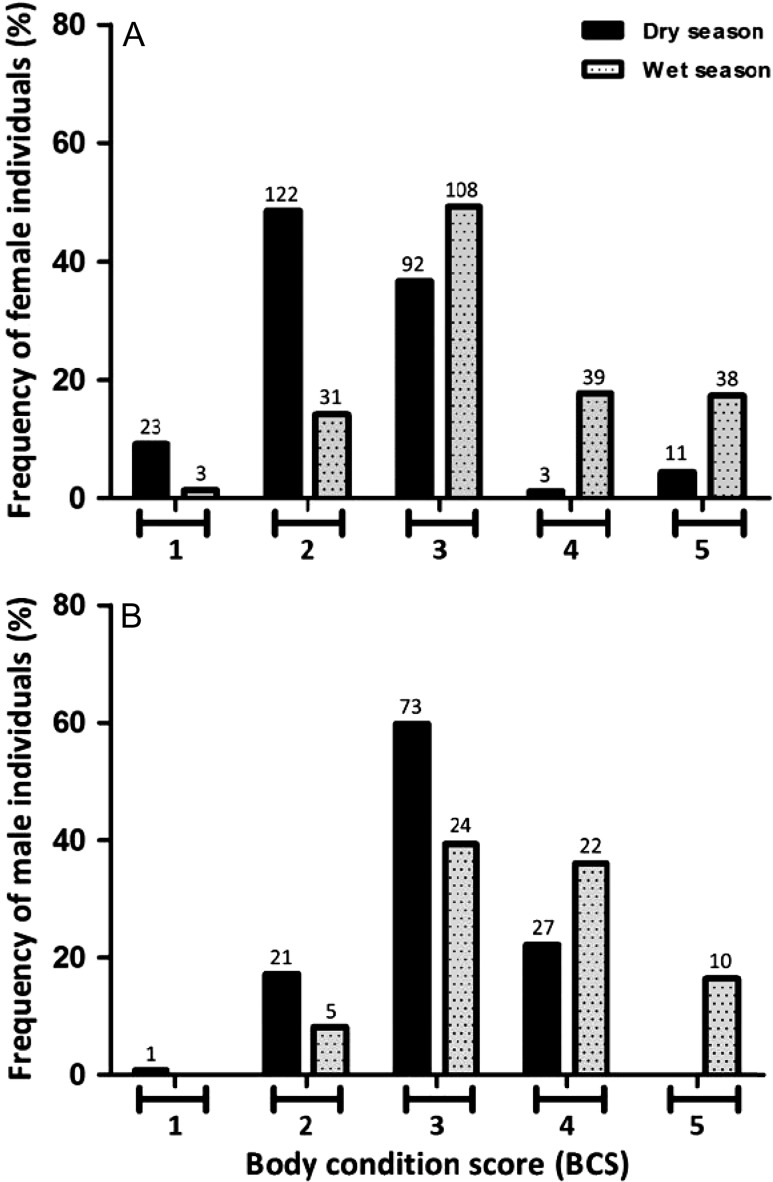
Proportion of elephants showing various BCS between dry and wet seasons. Bar plot representing: (A) frequency (%) of female individuals (n = 470) with different BCS in the two seasons; (B) frequency (%) of male individuals (n = 183) with different BCS in the two seasons. The number over each bar represents the sample size for that BCS (see text for statistical test results).